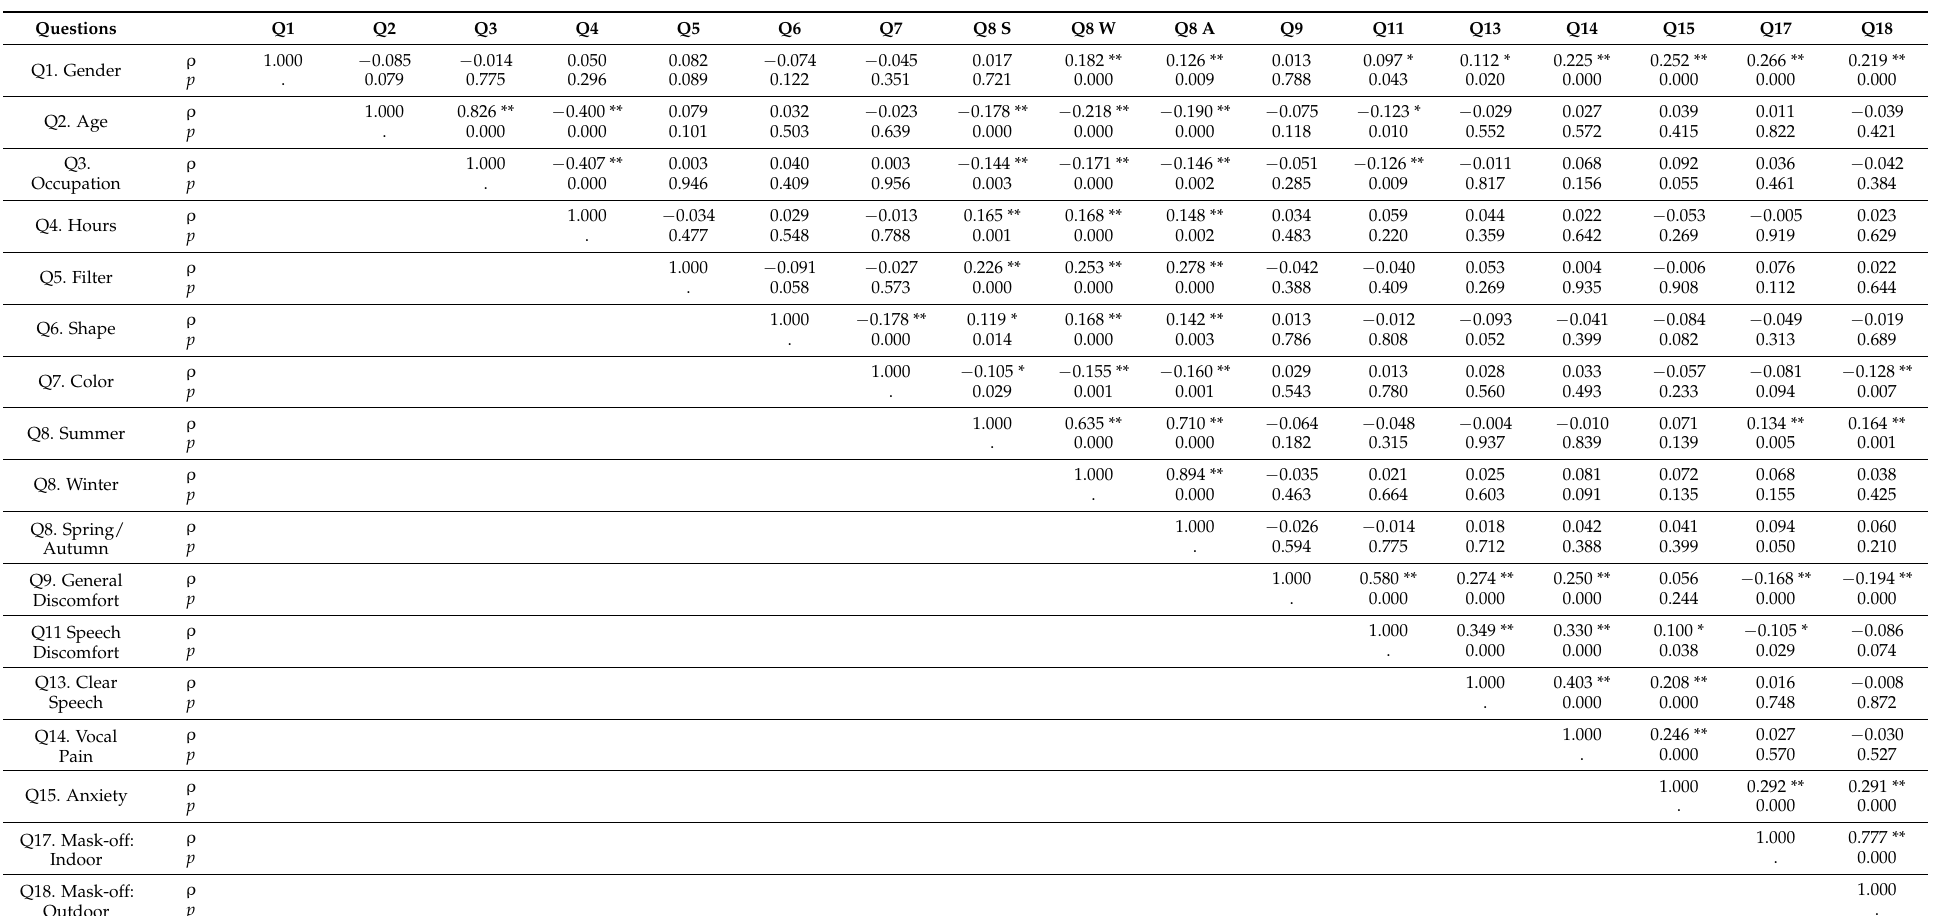
Table 5. Spearman’s rank correlation coefficients ( n = 433, ** p < 0.01, * p <